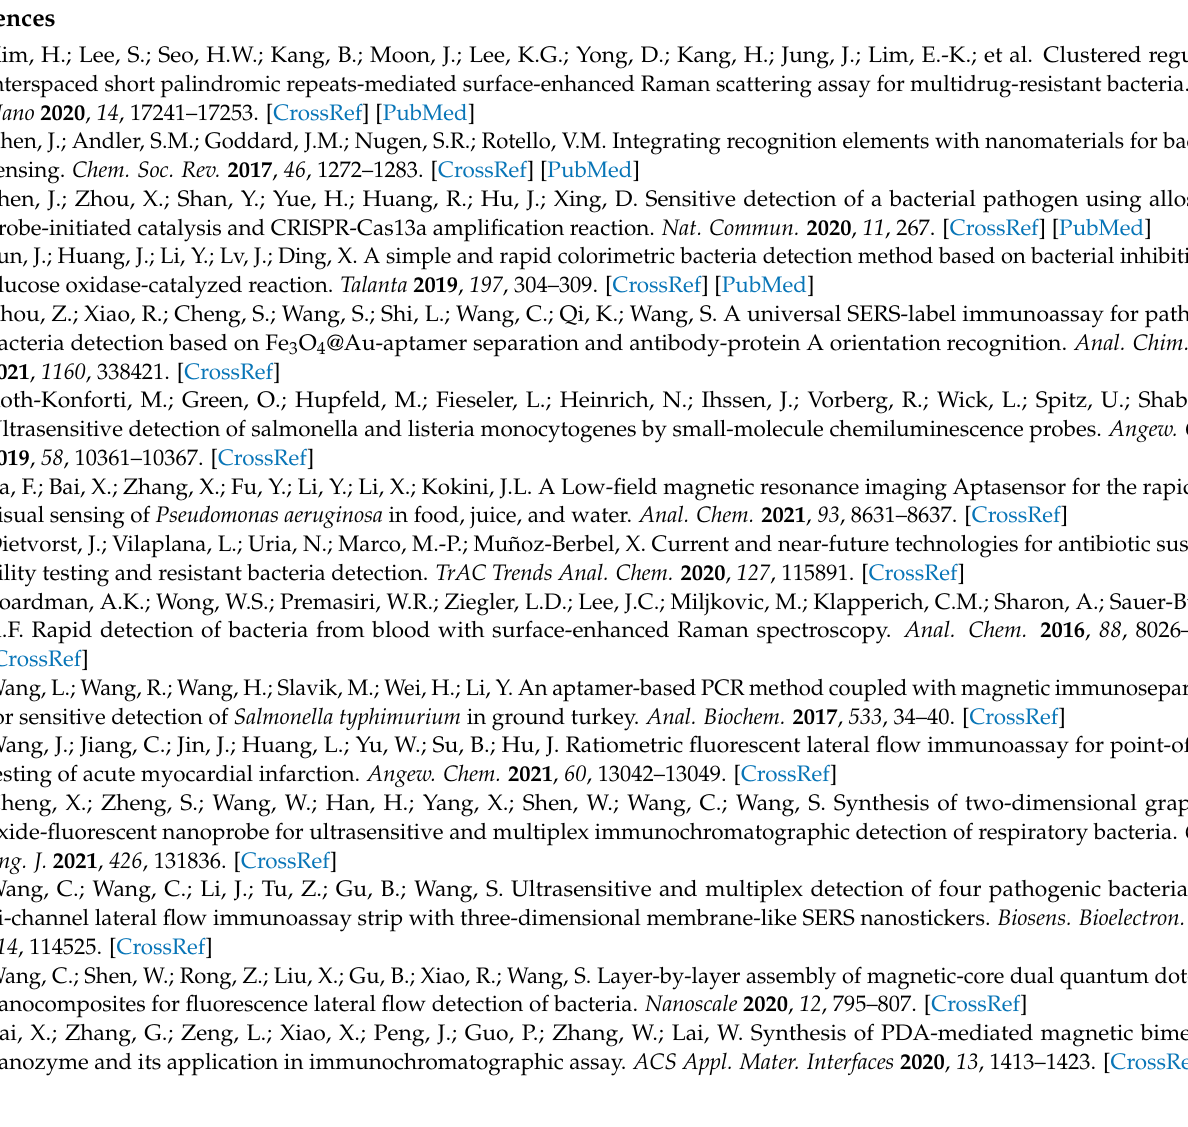
Figure S8: Optimization of P. aeruginosa and S. typhimurium reaction time on the test line for the LFA detection system. Figure S9: Photograph of LFA strip with C line for P. aeruginosa and Corresponding fluorescence intensity and calibration line for different concentrations of P. aeruginosa. Table S1: Recovery results of the bacteria in river water, cabbage juice, and orange juice. Table S2: Comparison of Mag@QD-WGA-LFA with other reported multi